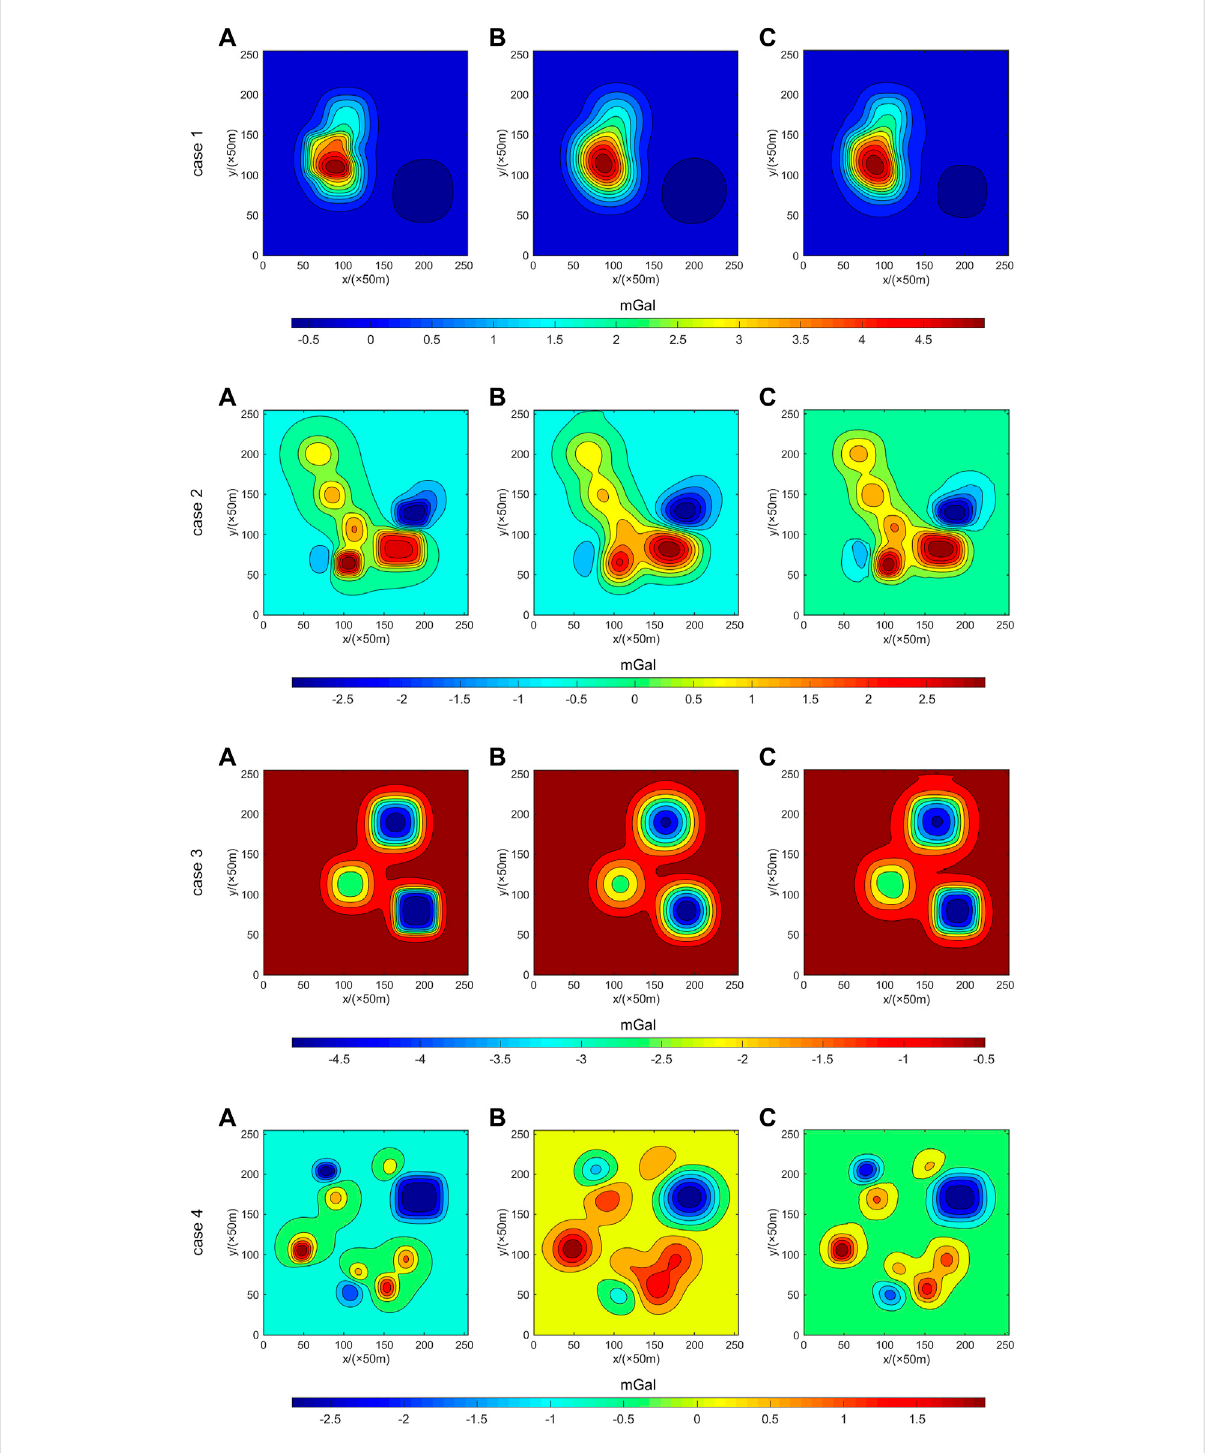
FIGURE 5 Comparison of four different cases between theoretical potential fi eld data (A) , Tikhonov regularization (B) , and joint driven data ( 2 input ) (C)